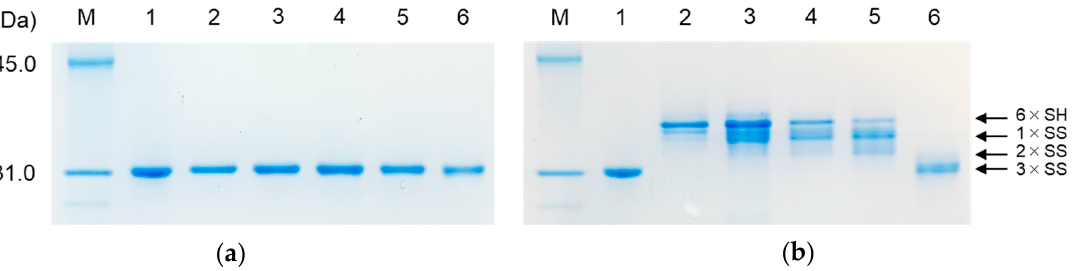
* The folding intermediates treated with the Male-Arg 5 -Tyr-NH 2 reagent. † Peak a was purified by RP-HPLC, as shown in Figure 2b. ‡ The numbers correspond to the peak numbers of the labeled folding intermediates of prococoonase on RP-HPLC as described below.